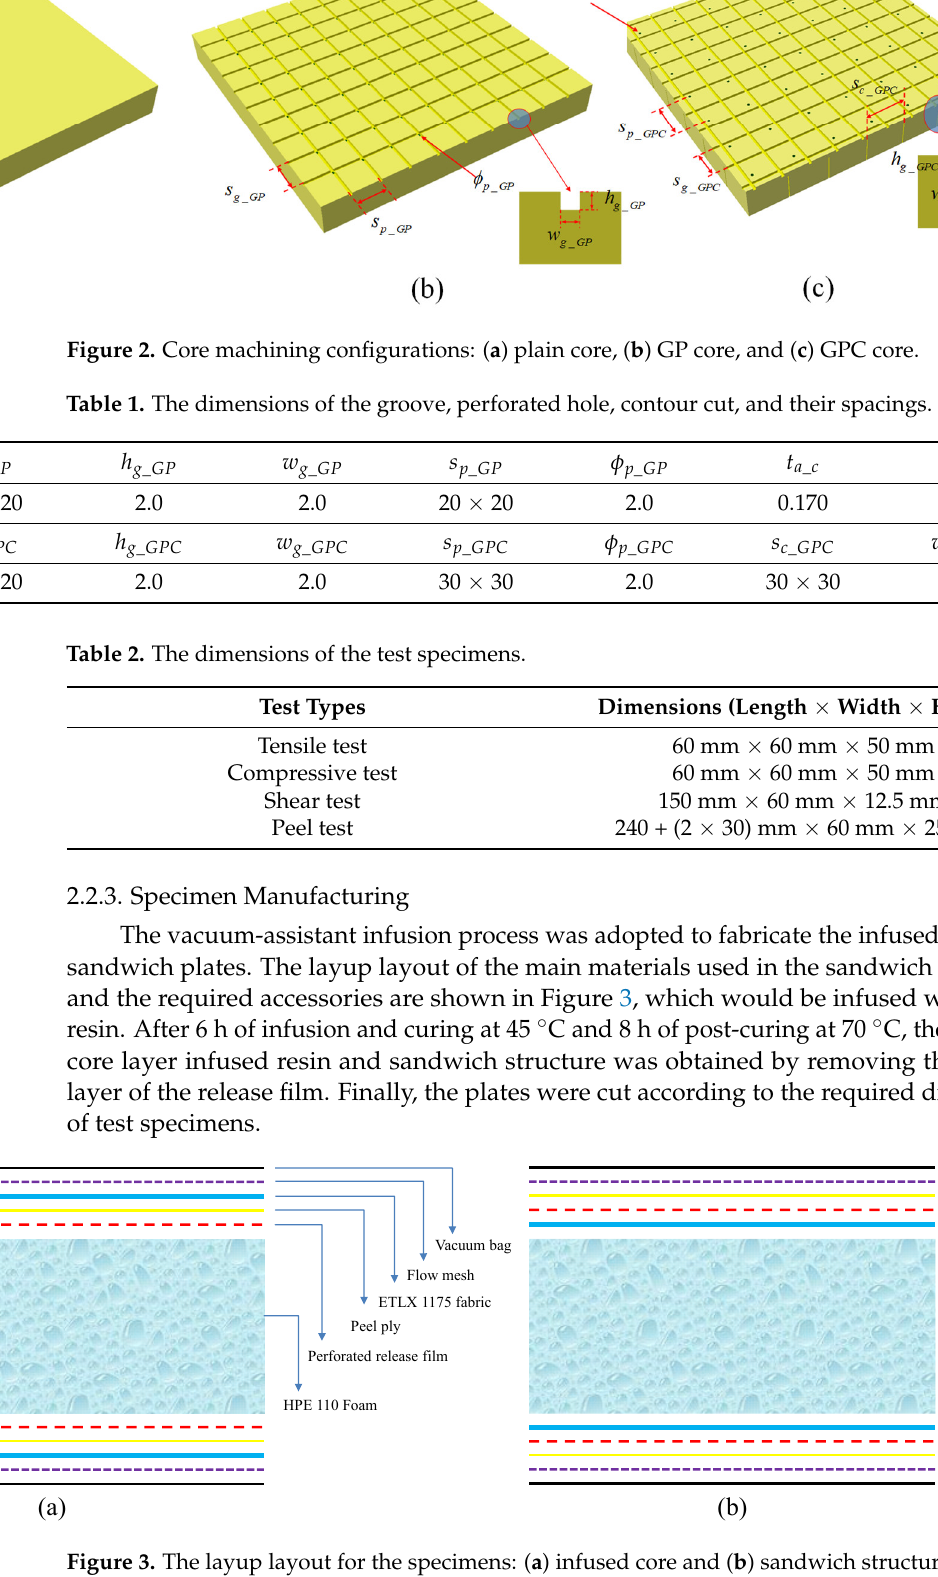
Figure 3. The layup layout for the specimens: ( a ) infused core and ( b ) sandwich structure.